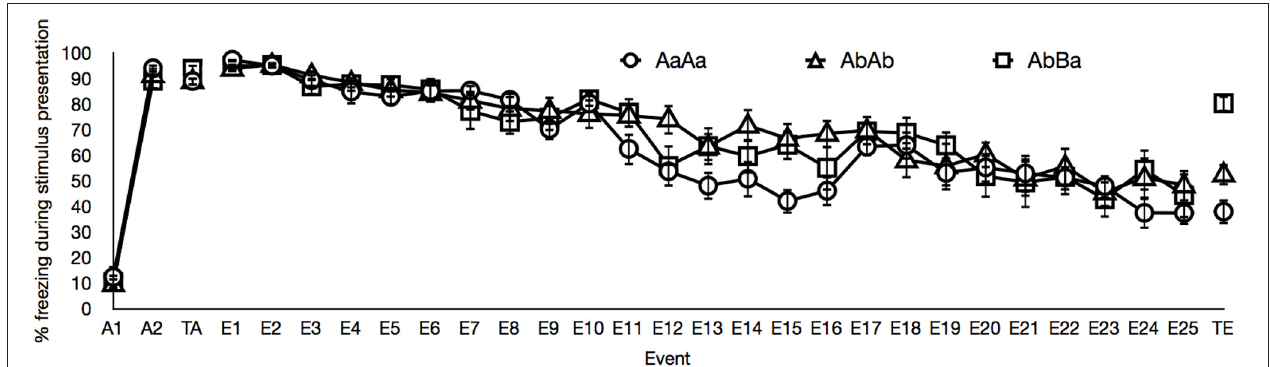
FIGURE 1 | Mean percentages of freezing for events of interest in the AaAa group (circles), in the AbAb group (triangles) and in the AbBa group (squares). The graph displays freezing during both acquisition trials (A1–A2), freezing averaged over the two generalization of acquisition test